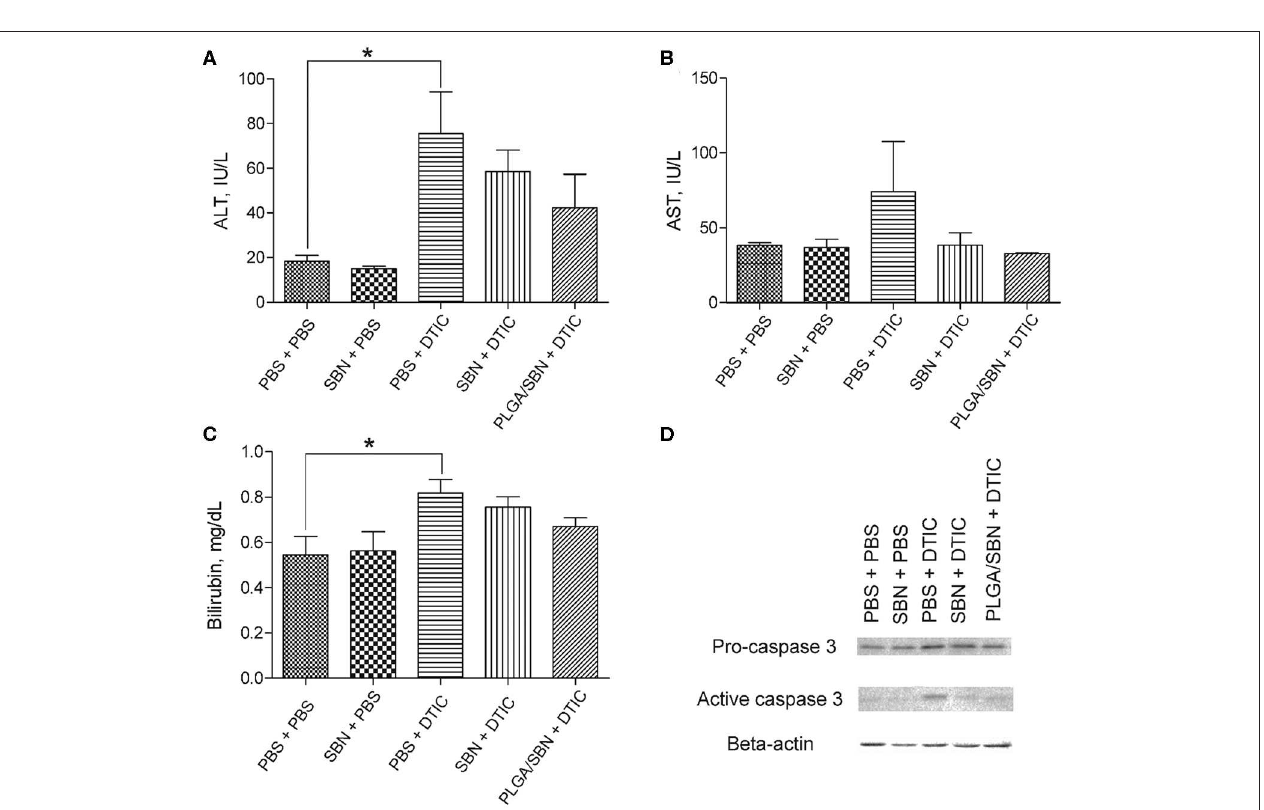
FIGURE 5 | Hepatoprotective efficacy of SBN formulation pre-treatment. (A) ALT and (B) AST levels in blood serum of tumor-bearing mice after experiment with DTIC therapy. (C) Bilirubin content in blood serum. (D) Pro-caspase 3 and active caspase 3 levels in livers of treated tumor-bearing mice determined by Western blot analysis. All values are shown as means ± SD. * P < 0.05 for (A,C) (one-way ANOVA followed by a post-hoc Dunnett’s t